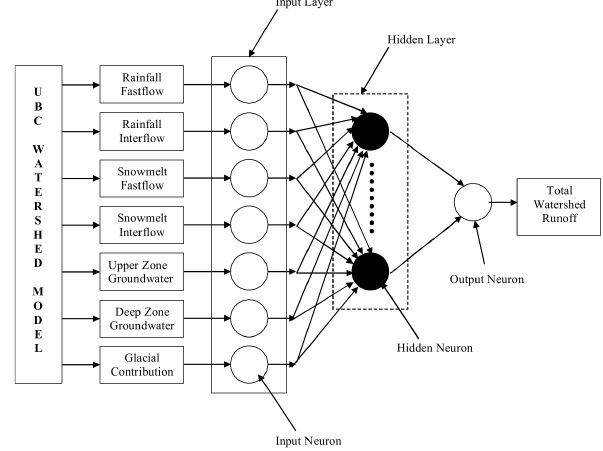
Figure 2. Typical ANN geometry for combining the outputs of the UBC watershed model in the methodology for poorly gauged wa-